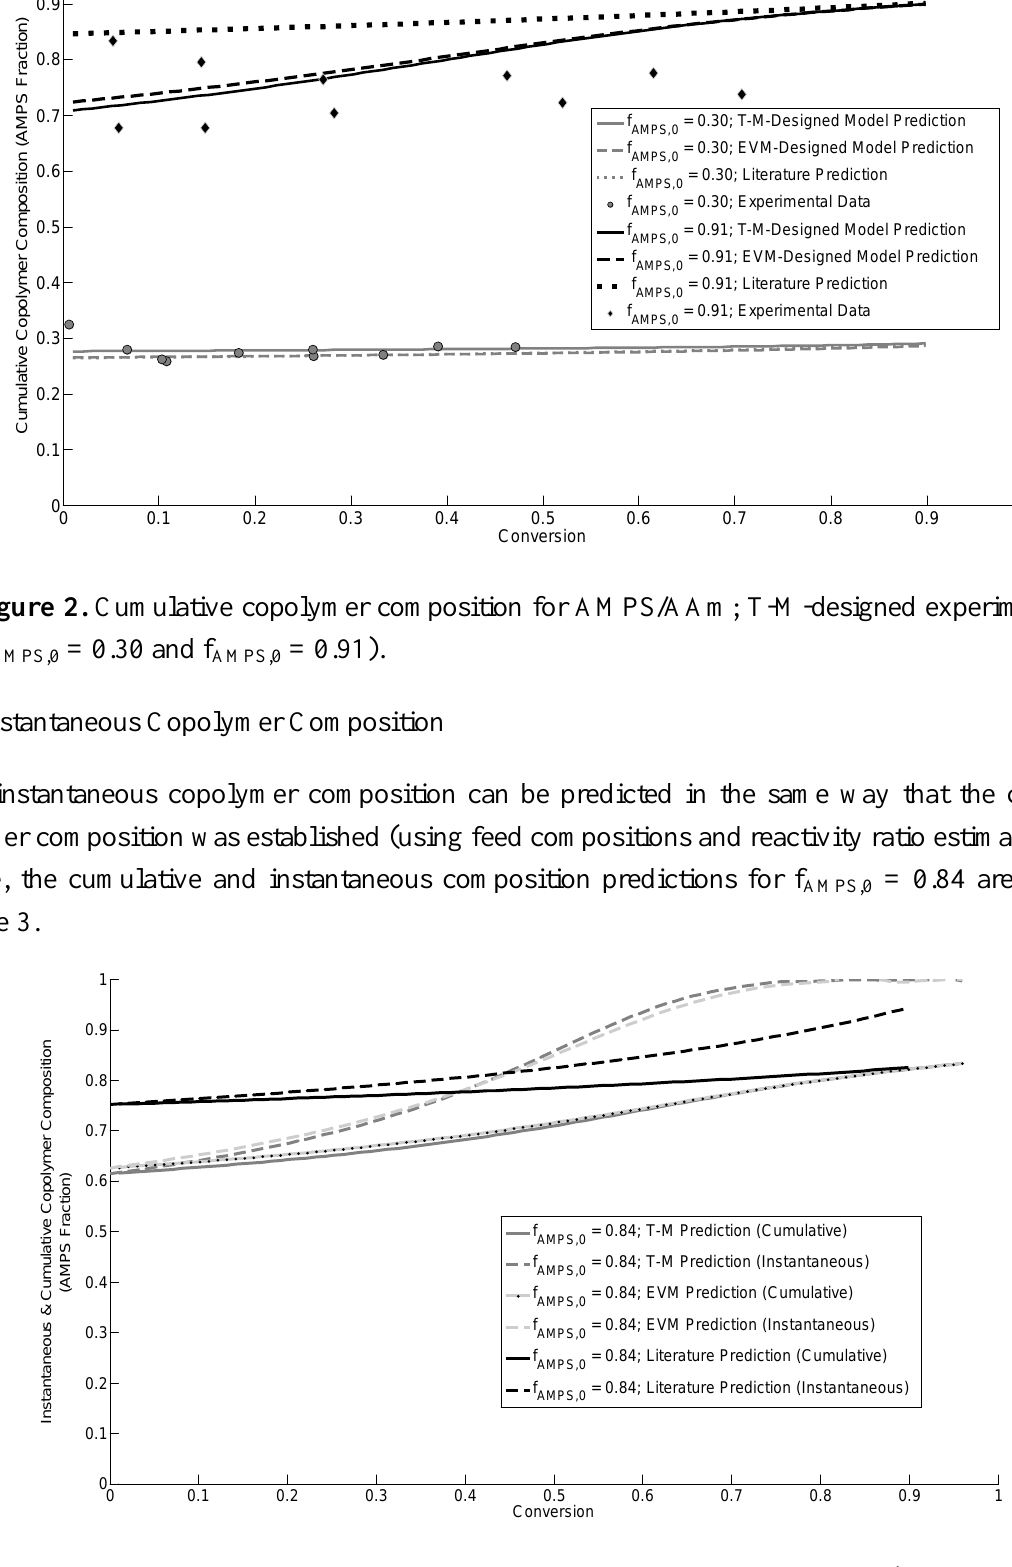
Figure 3. Instantaneous and cumulative copolymer composition predictions